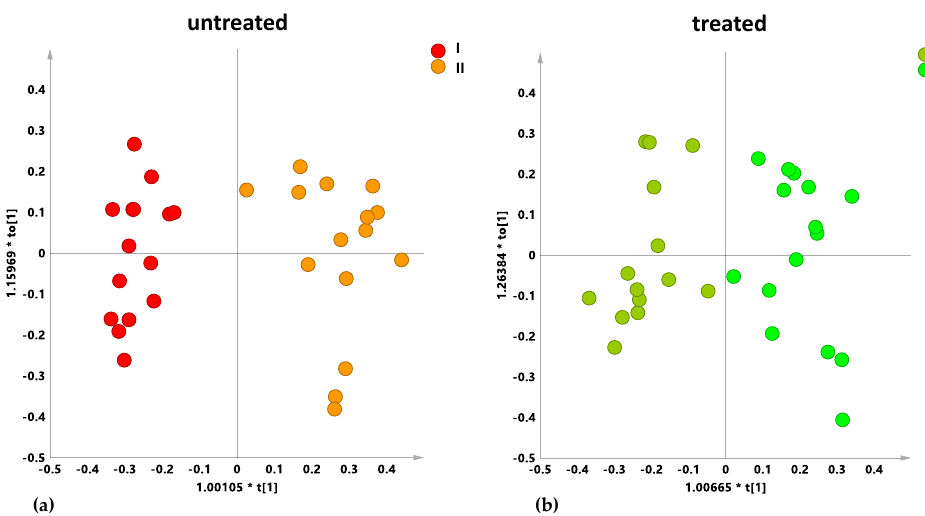
Figure 2. Orthogonal partial least square–discriminant analysis (OPLS-DA) t[1]/t[2] scores plot for untreated ( a ) and treated ( b ) naturally infected Leccino, Cellina di Nardò and Ogliarola salentina leaf samples comparing the I and II sampling periods.